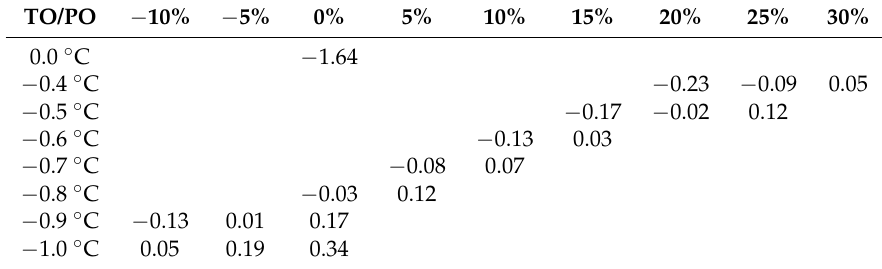
Table 4. Precipitation (PO) and air temperature offsets (TO) are combined to simulate steady-state conditions (m w.e. a − 1 ) for the LIA extent of Schiaparelli Glacier based on the adapted SRTM